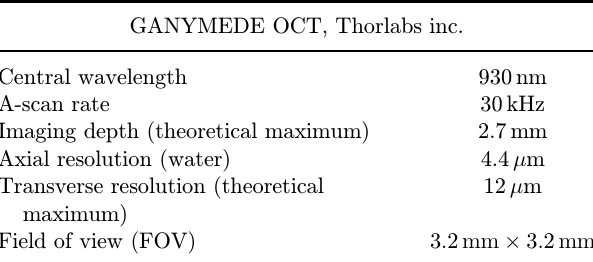
Table 1. Technical speci¯cations of the GANYMEDE OCT. GANYMEDE OCT, Thorlabs